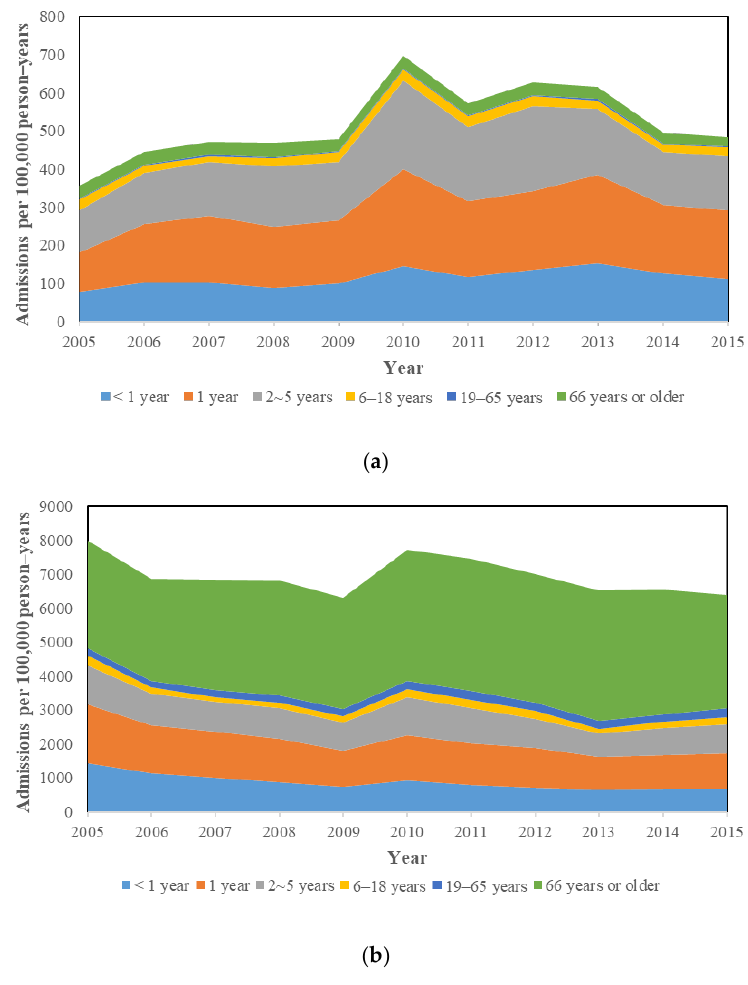
Figure 2. The hospitalization incidence rate of ( a ) pneumococcal and ( b ) unspecific community-acquired pneumonia during 2005–2015 by age group.